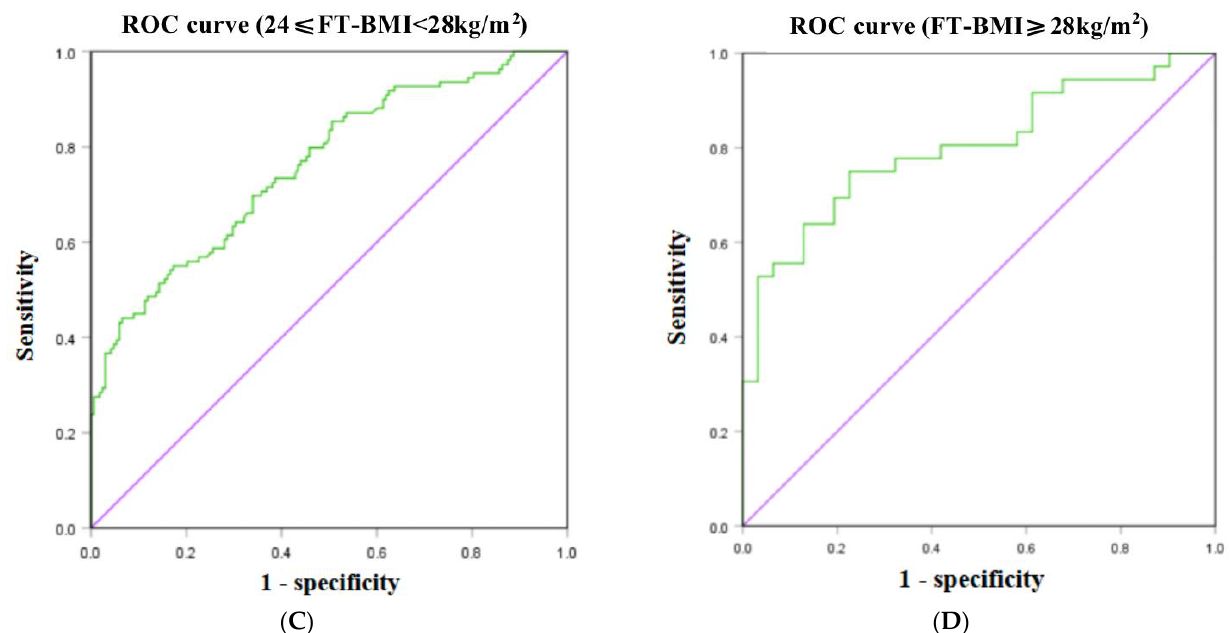
Figure 1. Ability of HOMA-IR in early pregnancy for predicting GDM in all participants ( A ), FT- BMI < 24 kg/m 2 subgroup ( B ), 24 ≤ FT-BMI < 28 kg/m 2 subgroup ( C ), and FT-BMI ≥ 28.0 kg/m 2 sub- group ( D ).